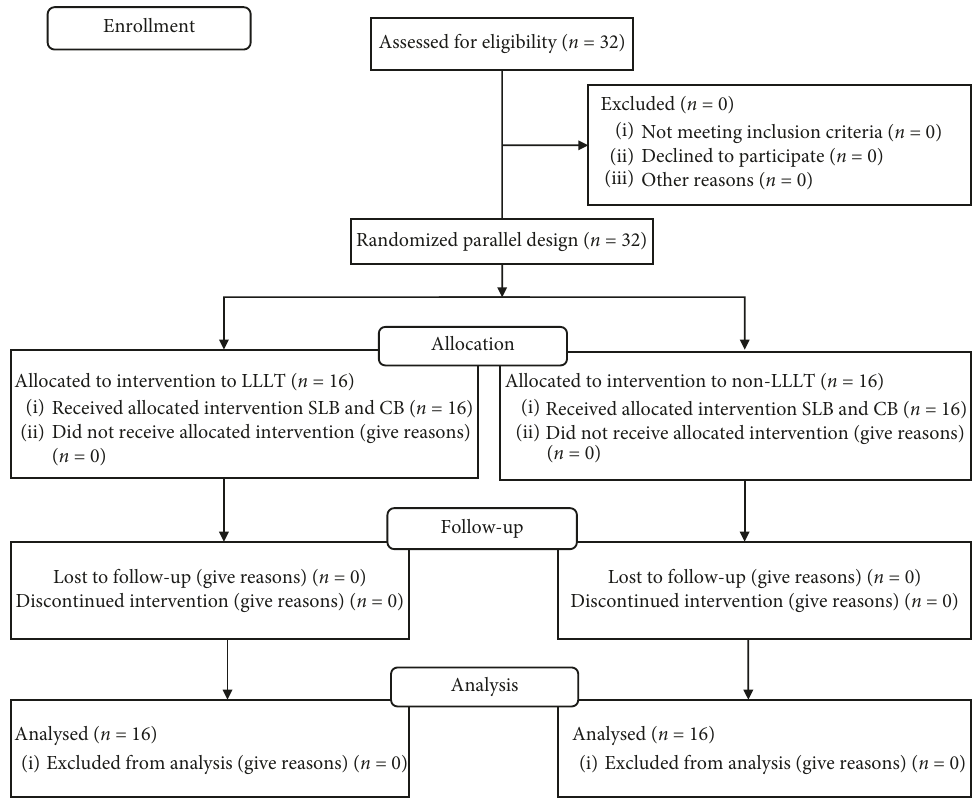
Figure 1: Consort flow